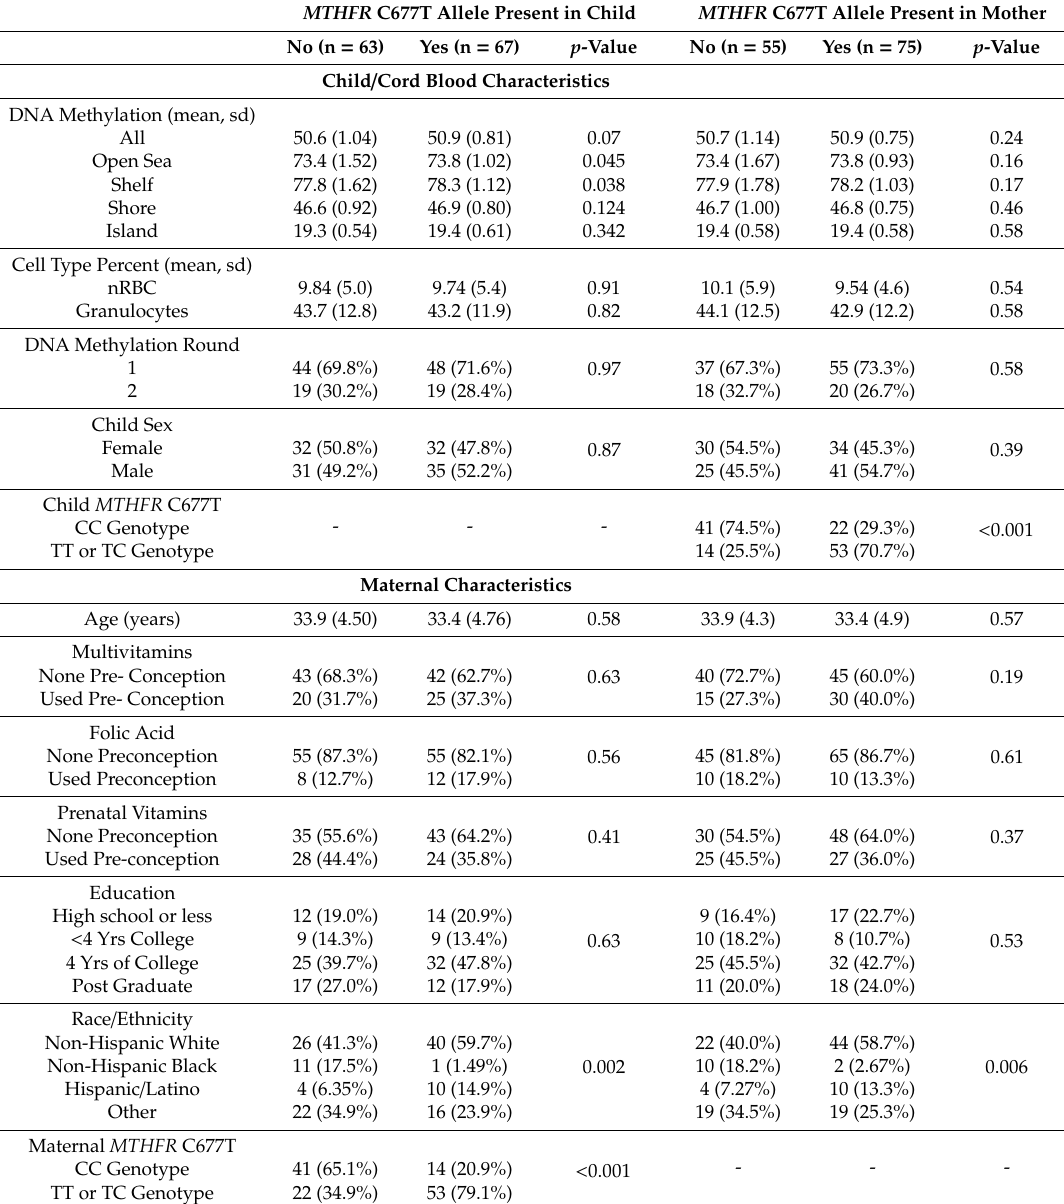
Table 2. MTHFR variant status by covariates in the Early Autism Risk Longitudinal Investigation (EARLI). p -values for difference in variables by multivitamin intake is from t-test for continuous variables, and chi- square test for categorical variables. Acronyms: Standard deviation (sd), methylenetetrahydrafolate reductase gene ( MTHFR ), cytosine (C), thymine (T), nucleated red blood cell (nRBC). MTHFR C677T Allele Present in Child MTHFR C677T Allele Present in Mother No (n = 63) Yes (n = 67) p -Value No (n = 55) Yes (n = 75) p -Value Child / Cord Blood Characteristics DNA Methylation (mean, sd)